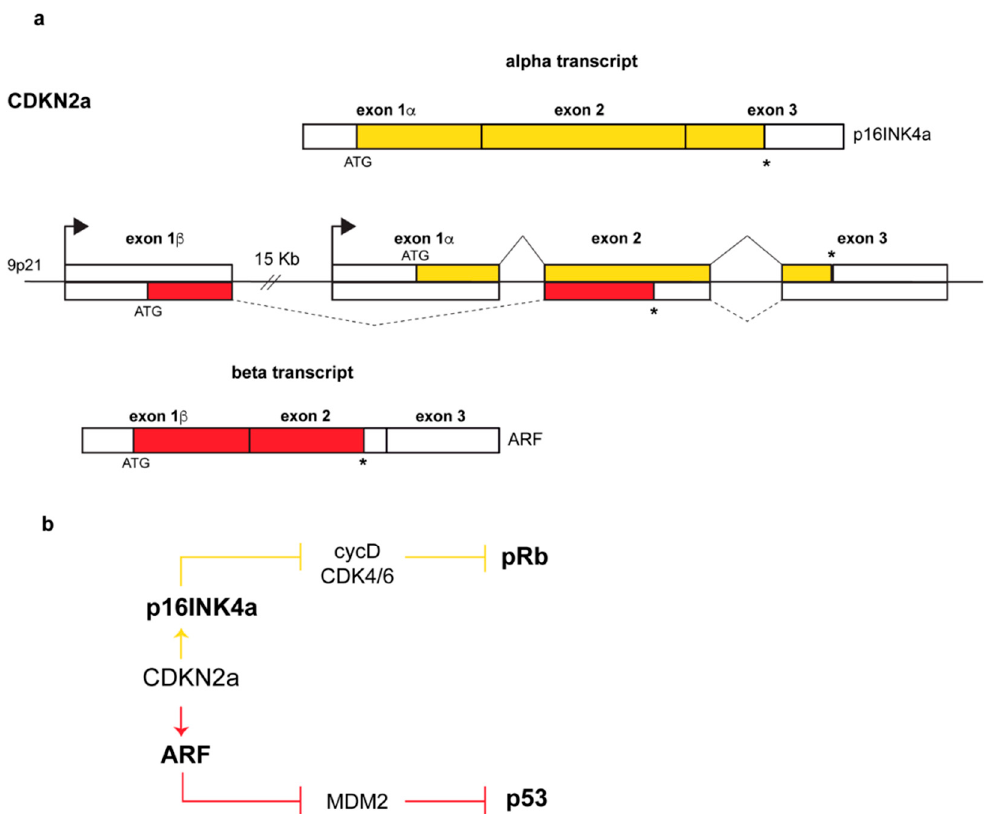
Figure 1. Genomic structure of the CDKN2a locus and produced transcripts. ( a ) Arrows above each exon 1 indicate promoters, continuous and dashed lines above and below the genomic structure indicate p16 and ARF splicing patterns respectively. Transcription of exon 1 β , and its splicing to exons 2 and 3 results in the α -transcript, encoding p16INK4a, whereas transcription starting upstream of exon 1 β produces the β -transcript in which the exon1 β , and the common exons 2 and 3 encode ARF (p14ARF in human, p19Arf in mouse). In yellow and in red are indicated the open reading frames (ORFs) of p16 and ARF respectively, with exon 2 displaying two overlapped ORFs. White boxes represent untranslated regions at the 3’ and 5’ ends while asterisks (*) indicate stop codons ( b ) Pathways regulated by the two proteins: while p14ARF inhibits Mdm2 (Mouse Double Minute-2) functions with consequential p53 stabilization [4,5], p16INK4a inhibits the cyclinD-CDK4/6 complex thus maintaining the retinoblastoma protein pRb in its growth-suppressive mode [4].